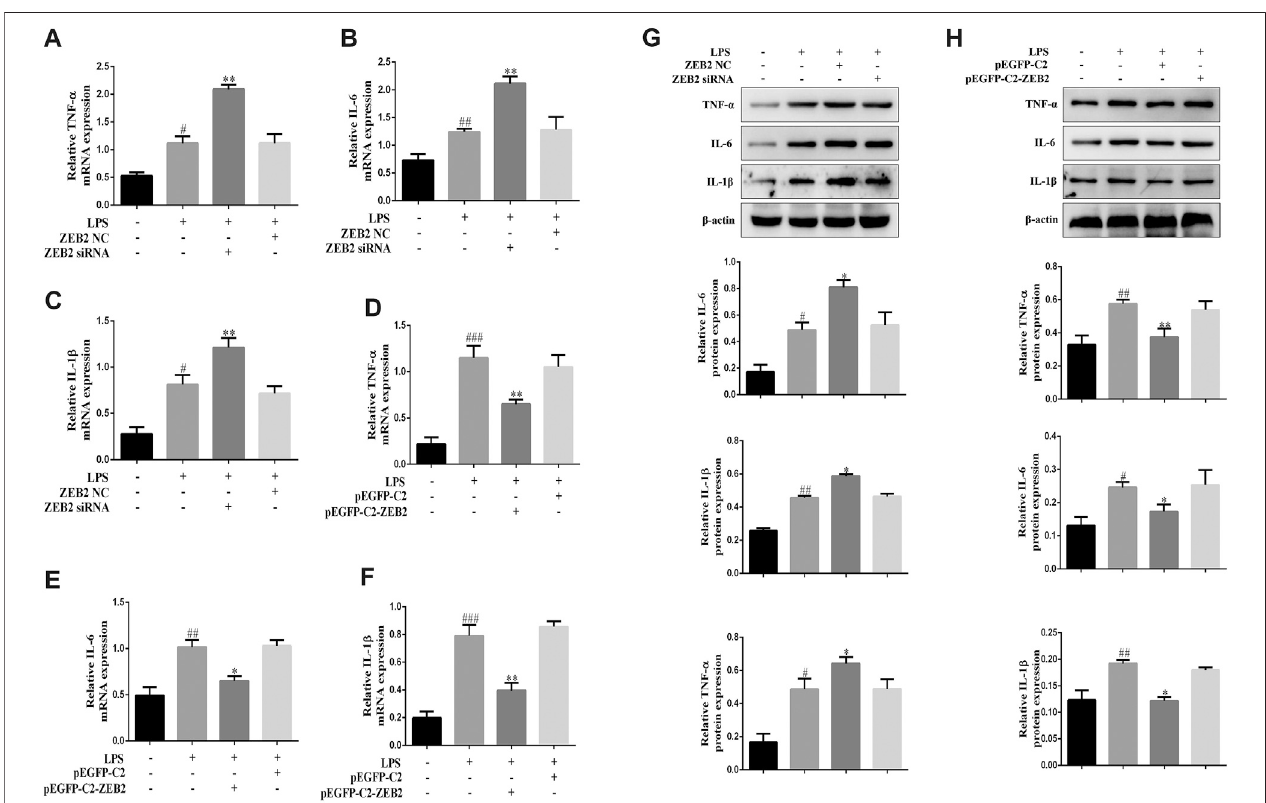
FIGURE5| ZEB2inhibitedtheexpression levels ofTNF- α , IL-1 β ,and IL-6in LPS-induced L-02cells. (A – F) : ThemRNA expression levels ofTNF- α ,IL-6, and IL-1 β were measured using qRT-PCR in L-02 cells transfected with ZEB2 siRNA and pEGFP-C2-ZEB2. (G) and (H) : The protein expression levels of TNF- α , IL-6, and IL-1 β were measured using WB analyses in L-02 cells transfected with ZEB2 siRNA and pEGFP-C2-ZEB2. The assays were performed at least three times, with similar results.Dataareshownasthemeans ± SD( n (cid:2) 3)ofonerepresentativeexperiment; ###p < 0.001and ##p < 0.01, #p < 0.05versusnormalgroups; **p < 0.01and *p < 0.05 versus the LPS